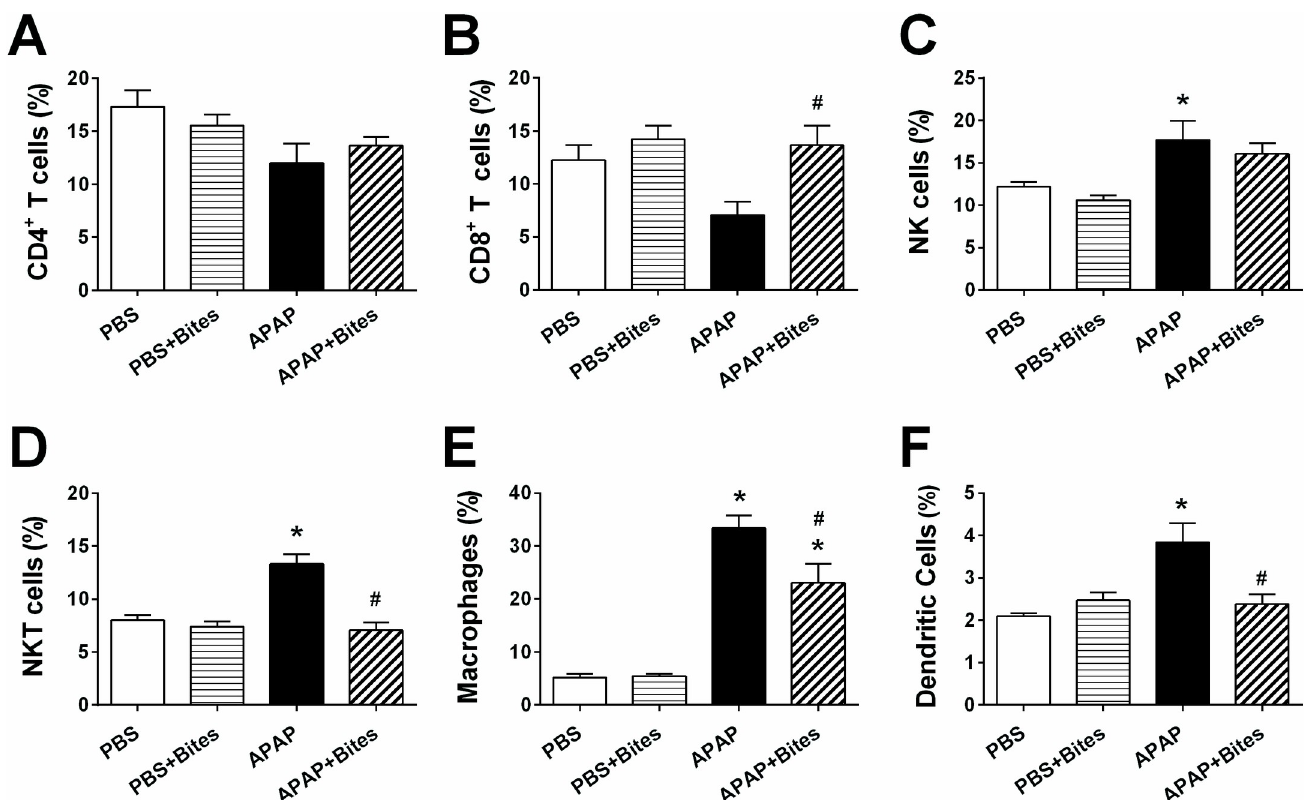
Fig 5. Liver immunophenotyping in mice injected with APAP and exposed to Ae . aegypti bites. C57BL/6 male mice were injected with PBS or APAP (300 mg/kg i.p.) and, after 2 hours, exposed to 30 Ae . aegypti mosquitoes. Liver samples collected 24 hours after injection were processed and immunophenotyping of hepatic cells was performed by flow cytometry. A. CD4 + T cells; B. CD8 + T cells; C. NK cells; D. NKT cells; E. Macrophages; and F. Dendritic cells. The data represent the mean ± SEM ( n = 4–14). � p < 0.05 versus “PBS” group; # p < 0.05 versus “APAP”